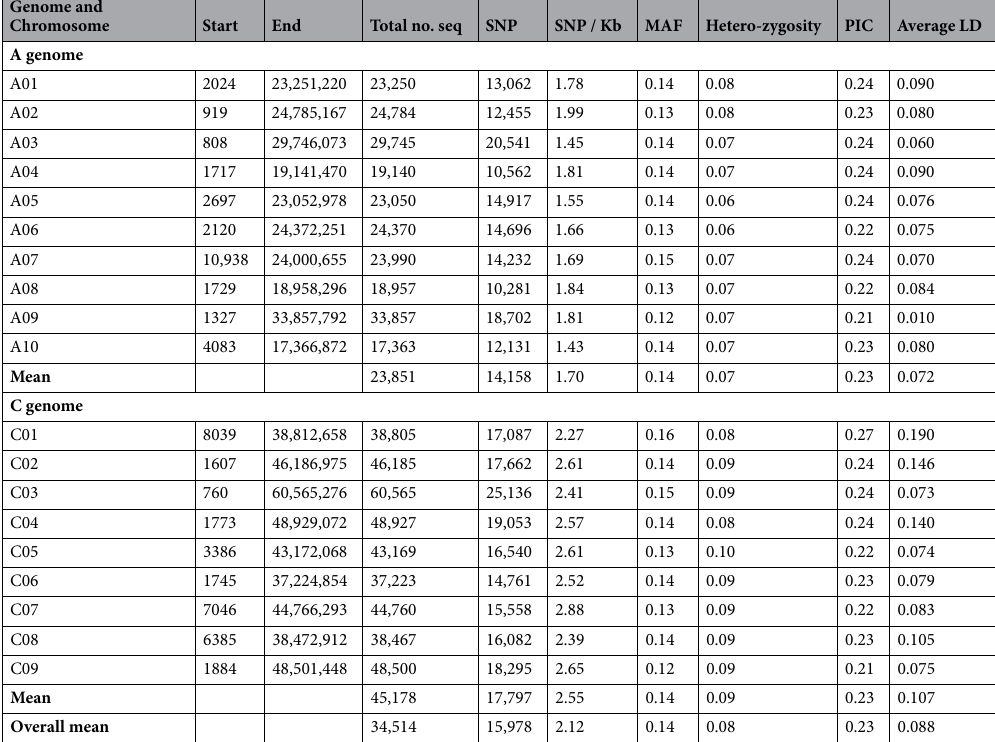
Table 2. Distribution of SNPs, minor allele frequency (MAF), heterozygosity, polymorphic information content (PIC) and linkage disequilibrium (LD) on each chromosome in the A and C genomes of 117 accessions of Brassica napus.